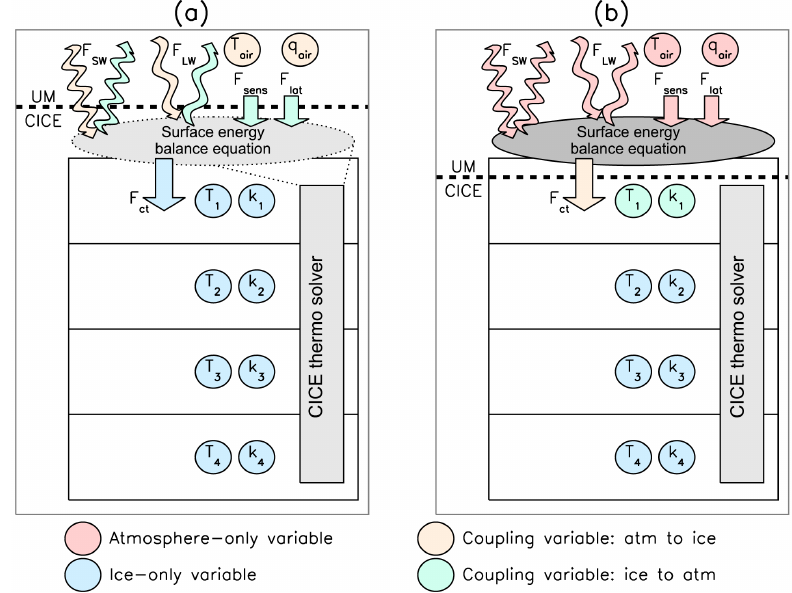
Figure 1. Schematics demonstrating (a) the CICE coupling method; (b) the JULES coupling method. In this figure F SW , F LW , F sens , and F lat denote fluxes of shortwave radiation, longwave radiation, sensible, and latent heat, respectively; F ct , the conductive flux from the surface to the ice; T air and q air , the temperature and humidity of the lowest atmospheric layer; and T j and k j , the temperature and effective conductivity of ice layer j